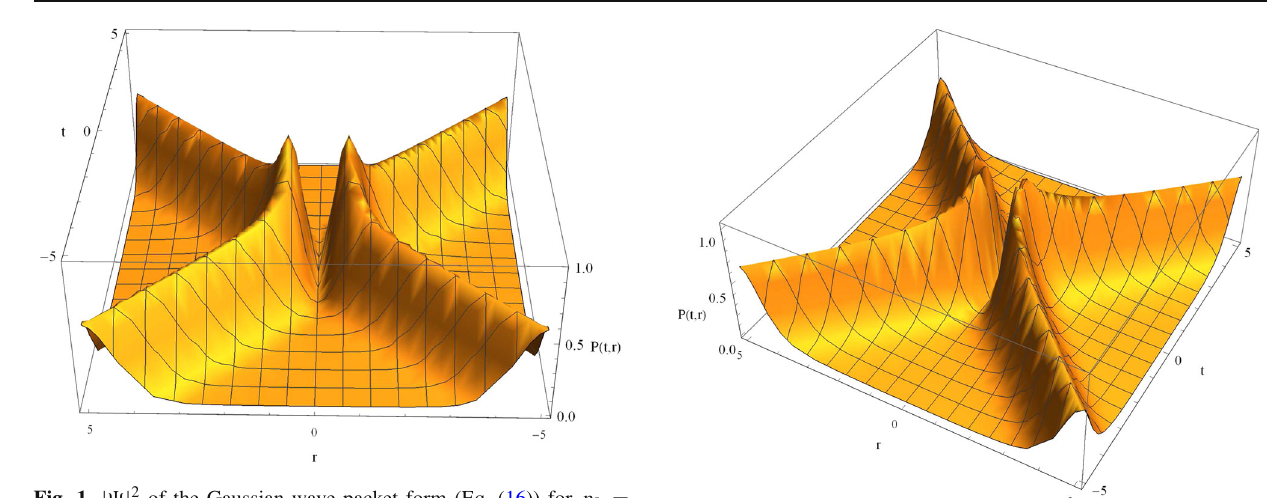
Fig. 1 | (cid:4) | 2 of the Gaussian wave packet form (Eq. (16)) for p 0 = σ = 1